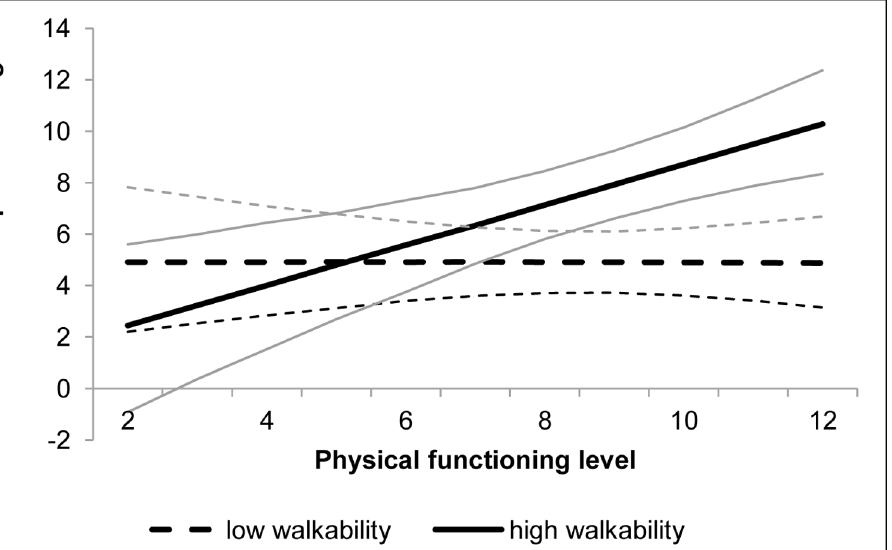
Fig 1. Interaction between physical functioning and neighborhood walkability for the predicted transport walking. Plot represents the predicted transport walking of the square root transformed variable for high-walkability (thicker full line) and low-walkability (thicker dashed line) neighborhood residents, and their confidence intervals (thinner full and thinner dashed